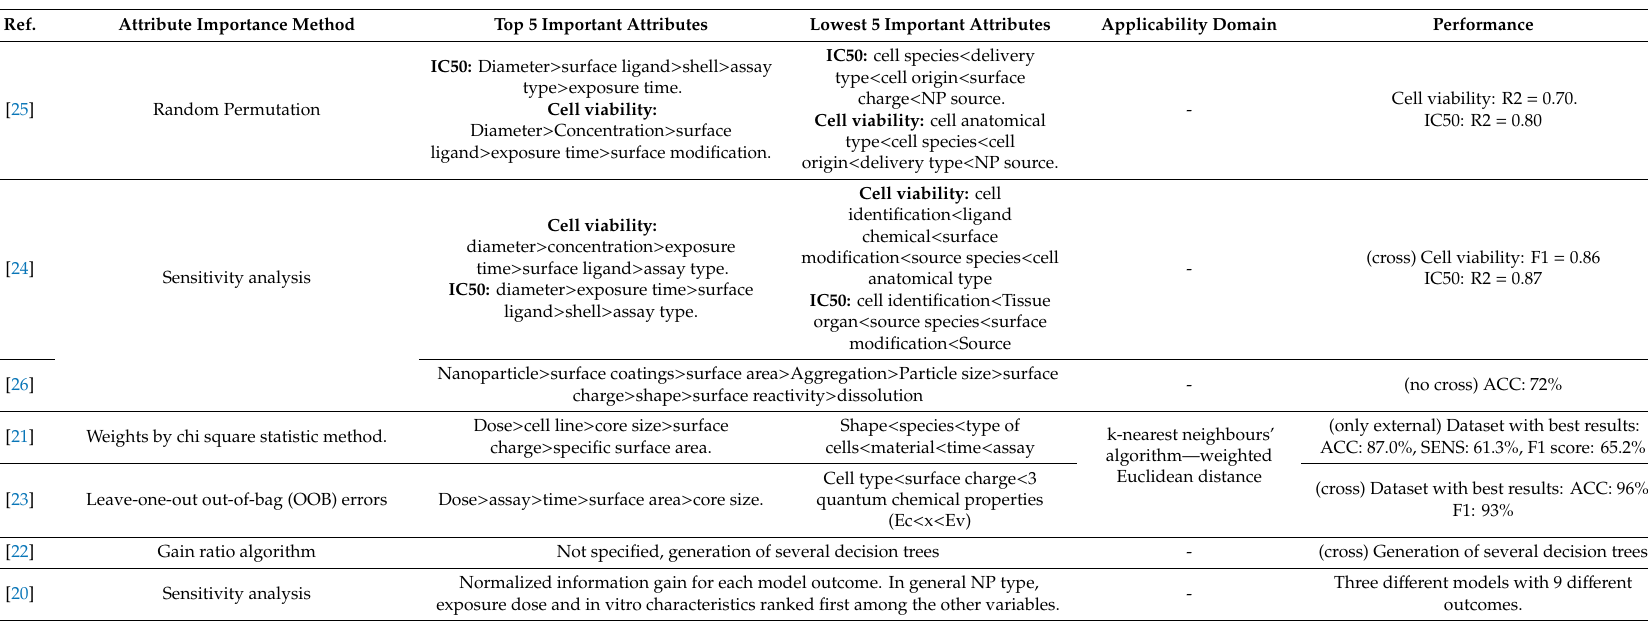
Table 7. In silico available tools in the literature capturing neurotoxicity. Attribute importance methodology along with the top five and lowest five attributes are shown for relevant outcomes (in bold). In addition, applicability domain and performance metrics and results are shown.